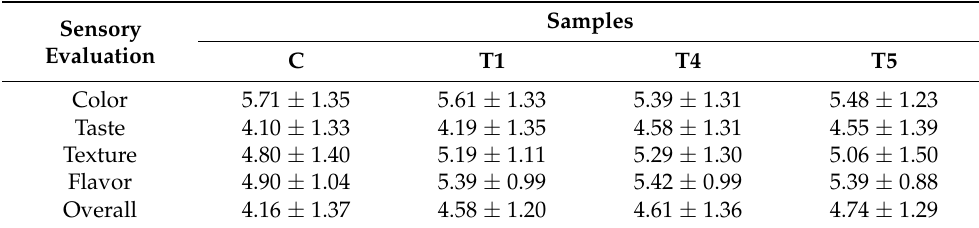
Table 1. Consumer panelist ratings for the yogurt samples on a 7-point